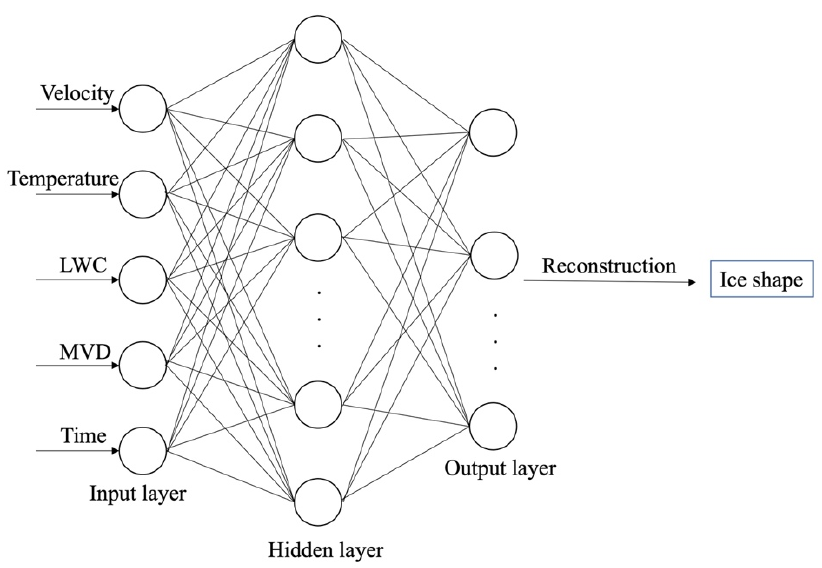
Figure 6. Schematic diagram of neural network structure [55] .